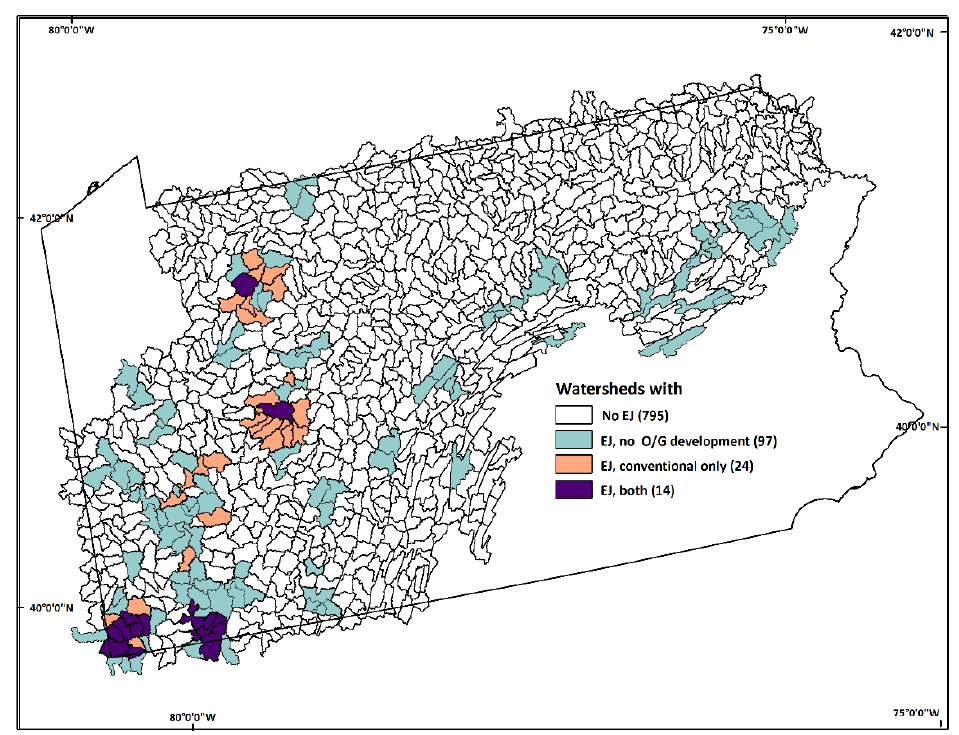
Figure 7. Oil and gas development in relation to environmental justice (EJ) areas as defined by the State of Pennsylvania . Values in parentheses are the number of watersheds. Some of the watersheds labeled as “EJ, none” in this figure are labeled as having oil and gas development in Figure 3. In these watersheds, the oil and gas development did not occur in the portion of the watershed identified as an environmental justice area by the State. Table 5. Interior forest loss attributable to unconventional and conventional oil and gas exploration. The area in km 2 of interior forest is reported in the National Land Cover Database (NLCD) row, and loss attributable to conventional, unconventional or